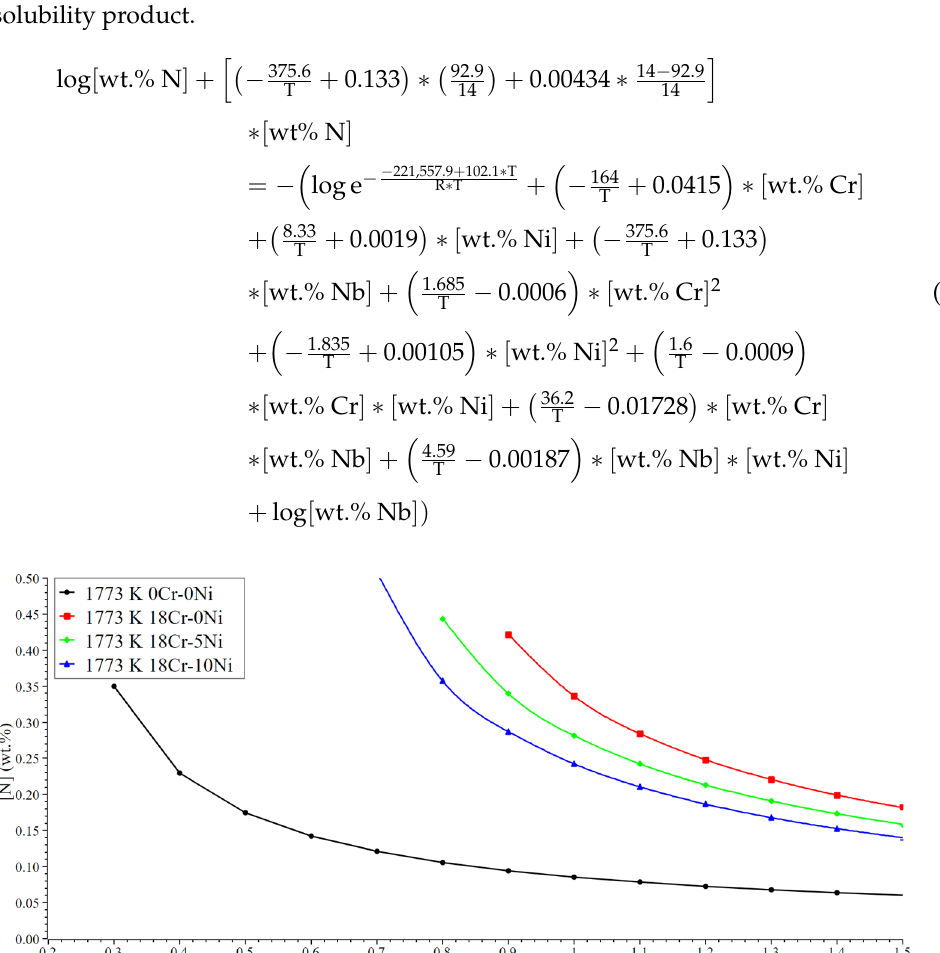
Figure 3. Effect of chromium and nickel addition on equilibrium solubility product of niobium and nitrogen in steel melt at 1773 K. nitrogen in steel melt at 1773